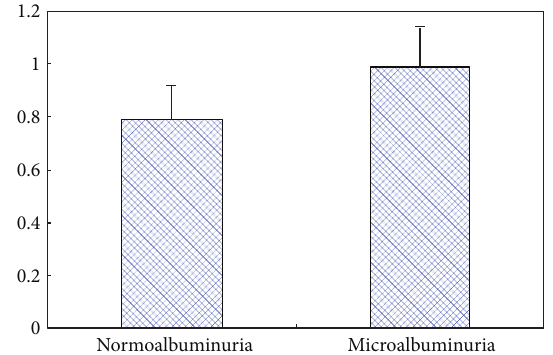
Figure 1: Comparison of IMT between the two study groups. Continuous variables were expressed as median and range. 𝑃 < 0.05 from the Wilcoxon rank-sum test for the difference between nor- moalbuminuria group and microalbuminuria group. IMT: intima- media